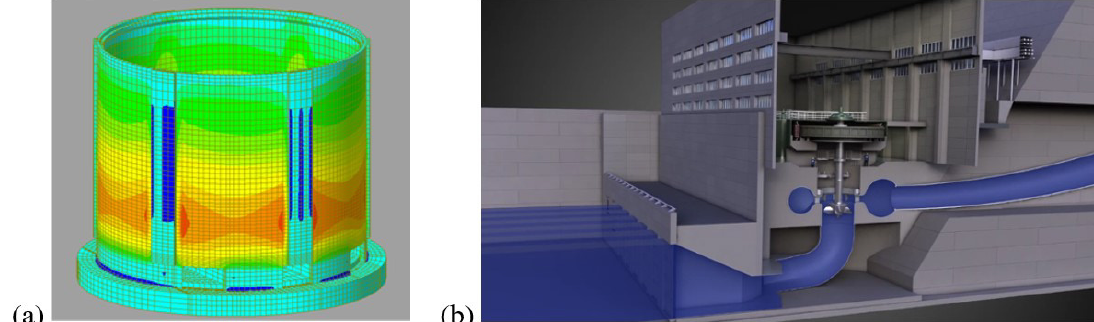
Figure 1. (a) Finite solid element model for a clinker storage silo of the Ramliya Cement Plant (Dianafea [1]); (b) concrete hydroelectric structure (Wikimedia Commons [2])